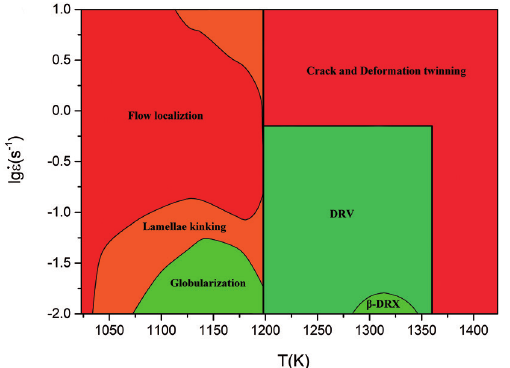
Figure 11: Microstructural deformation mechanism map for Ti- 6Al-4V-0.1Ru.